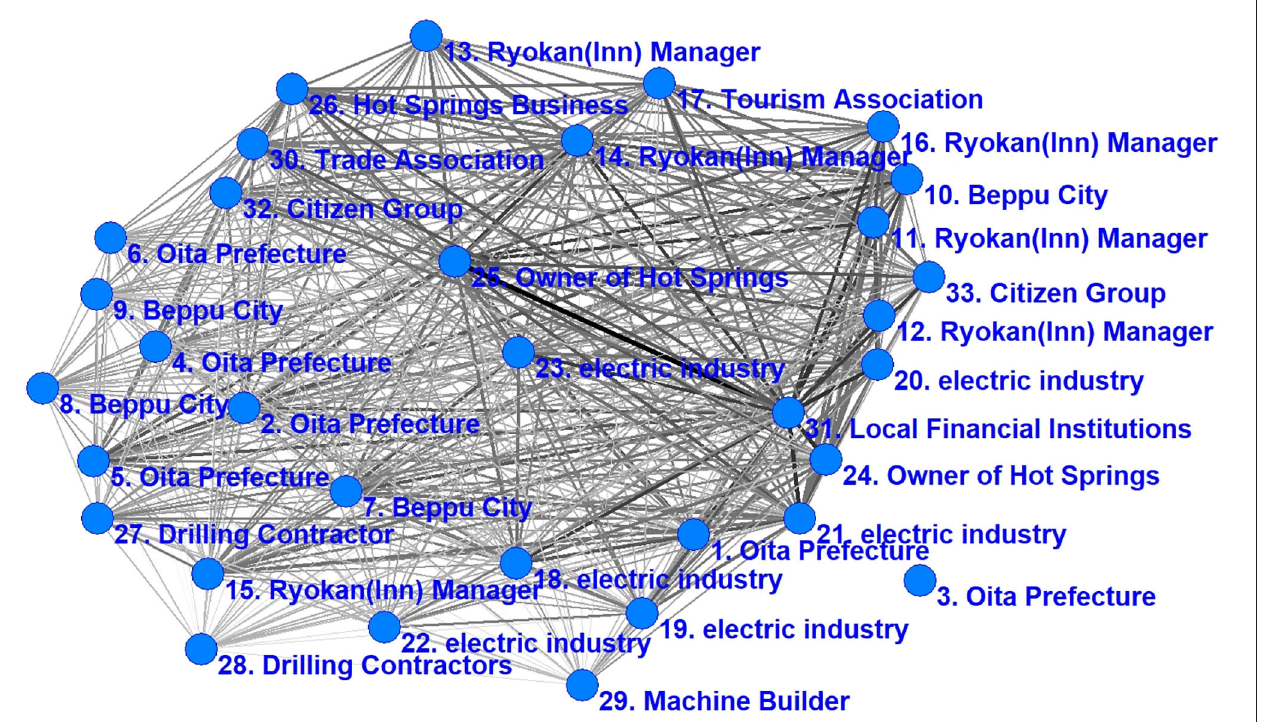
FIGURE 7 | Relationships among the stakeholders related to the geothermal resources in Beppu using social network analysis (Kimura et al.,